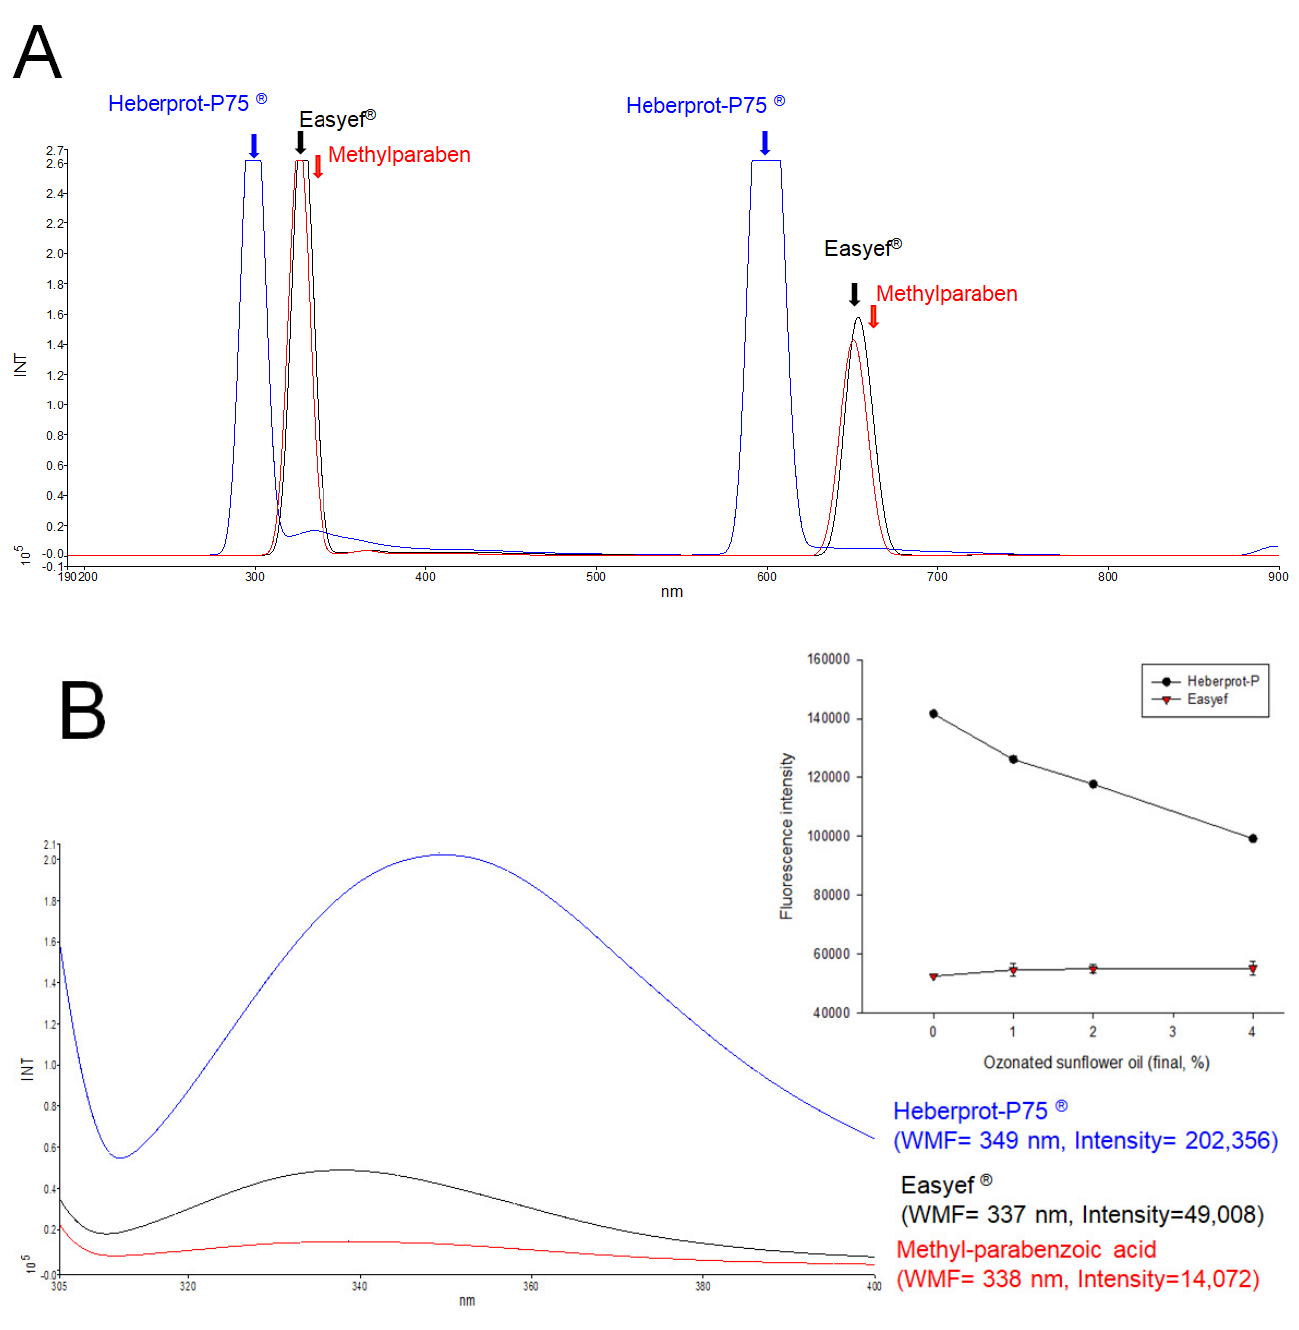
Figure 2. Fluorescence emission spectra of Heberprot-P75 ® , Easyef ® , and methyl-parabenzoic acid. ( A ) Pre-scan of full-range emission fluorescence spectrum 190–900 nm. ( B ) Wavelength maximum fluorescence (WMF) of Trp spectrum (Ex = 295 nm, Em = 305–400 nm). The inset graph shows the change in the fluorescence intensity depending on ozonated sunflower oil (OSO) treatment. In order to compare fluorophore properties, collisional quenching of Trp was performed by adding the OSO into Heberprot-P75 ® and Easyef ® .